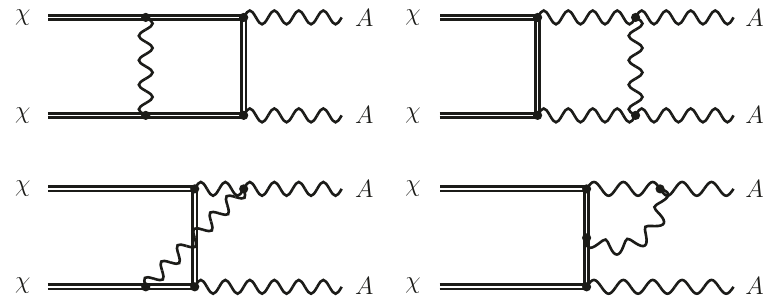
Figure 9 . Representative sample of one-loop diagrams contributing to the computation of the Wilson